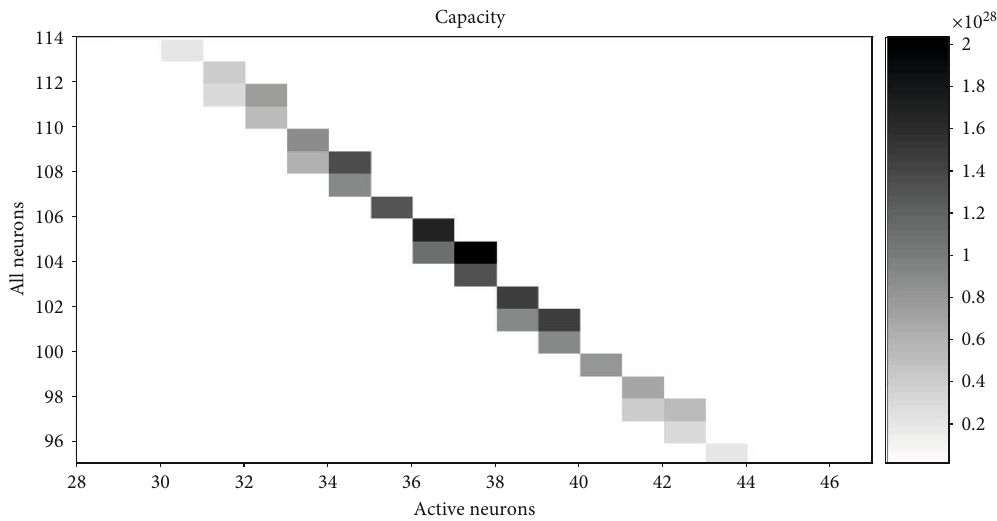
Figure 6: The representational capacity of di ff erent neural